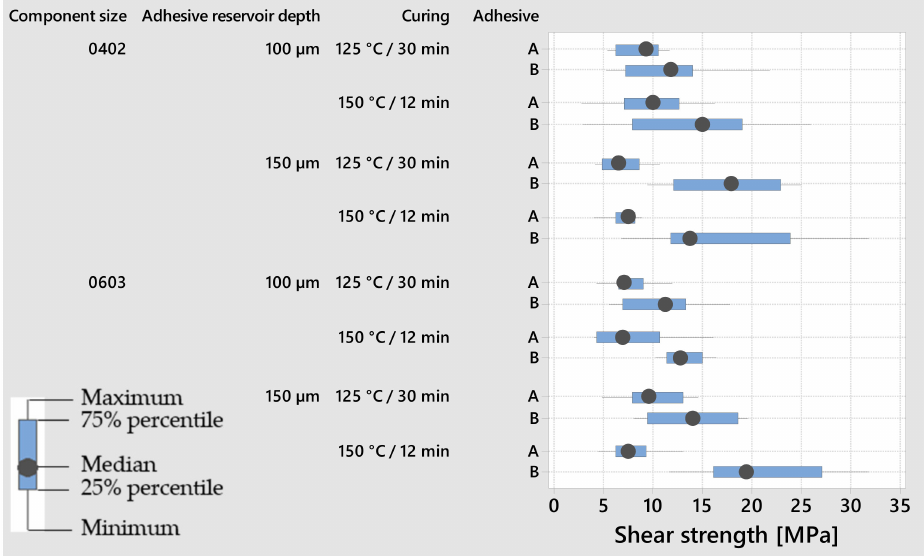
Figure 5. Shear strength of the conductively bonded SMDs on foil for the process